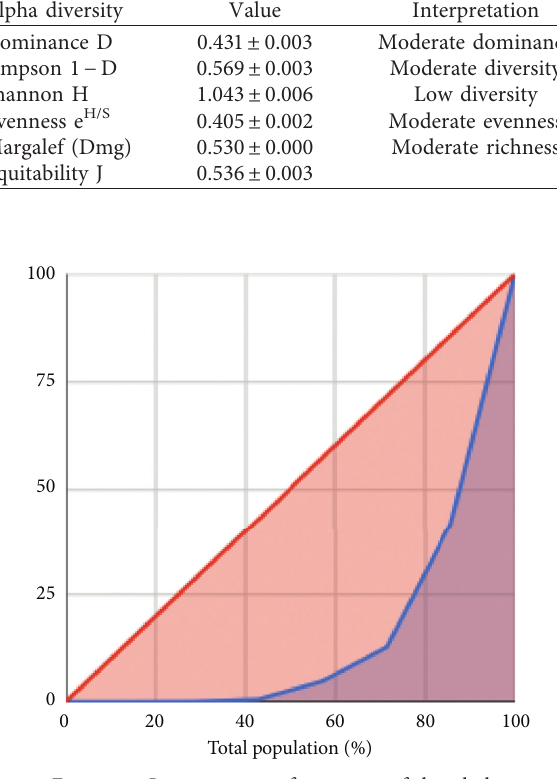
Figure 5: Lorenz curve of evenness of the phyla.